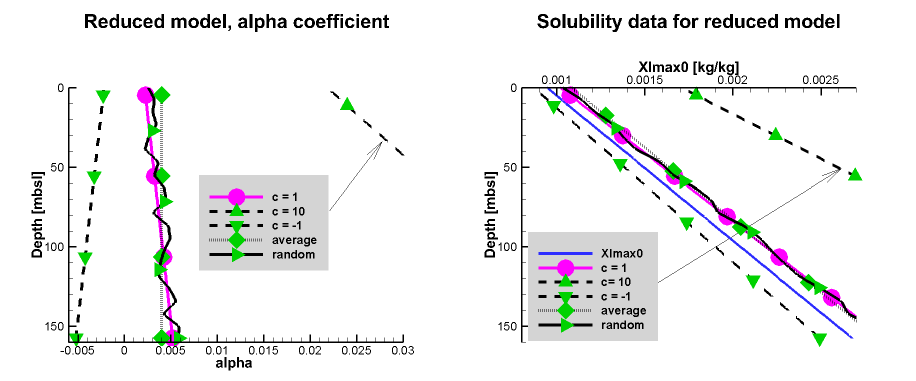
Figure 6. Parameter α ( x ) as a function of depth used in Section 5 ( left ) and the corresponding ( x ) computed from Equation (4) and assuming χ χ max ,0 lM is also shown. The base case from Ulleung Basin [3] in both plots is denoted with circles. The other cases correspond to c = − 1, c = 10, the average of α ( x ) , and to a randomly perturbed α ( x ) . The plots for c = 10 are out of range and are not fully included.